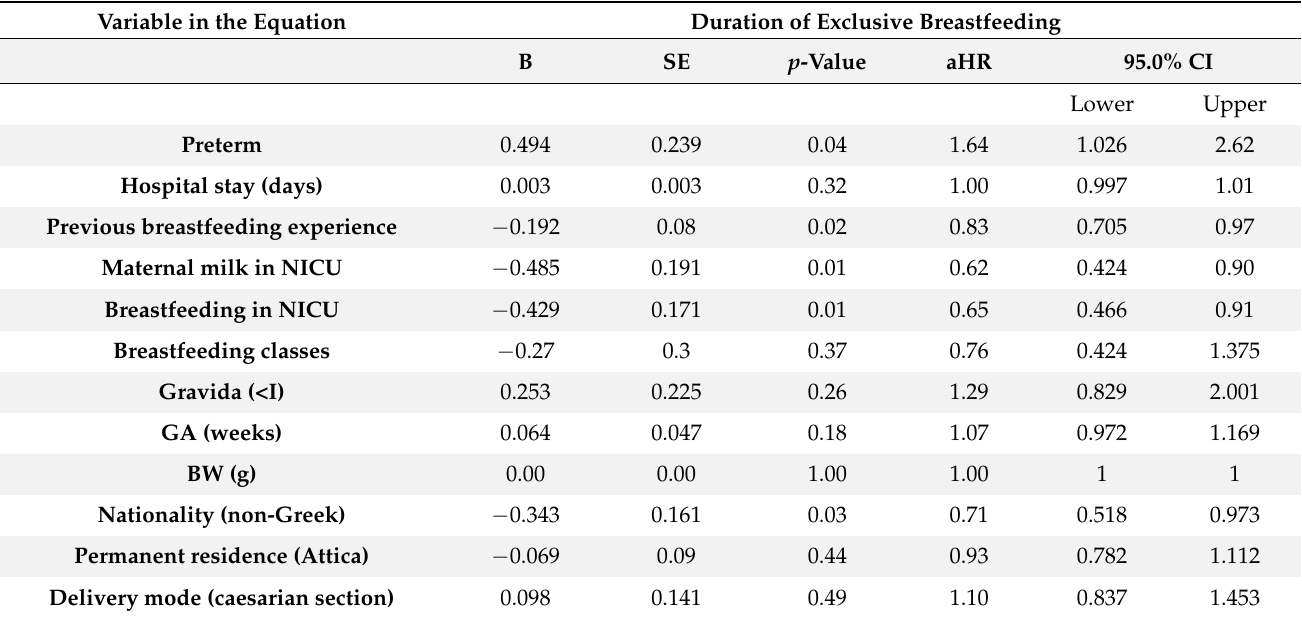
Table 4. Prognostic factors associated with duration of exclusive breastfeeding (Cox proportional hazards regression analysis, N = 279).